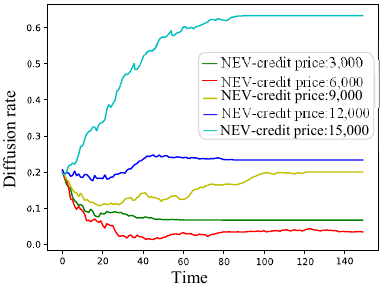
Figure 13. Affiliated rate, Scale free.